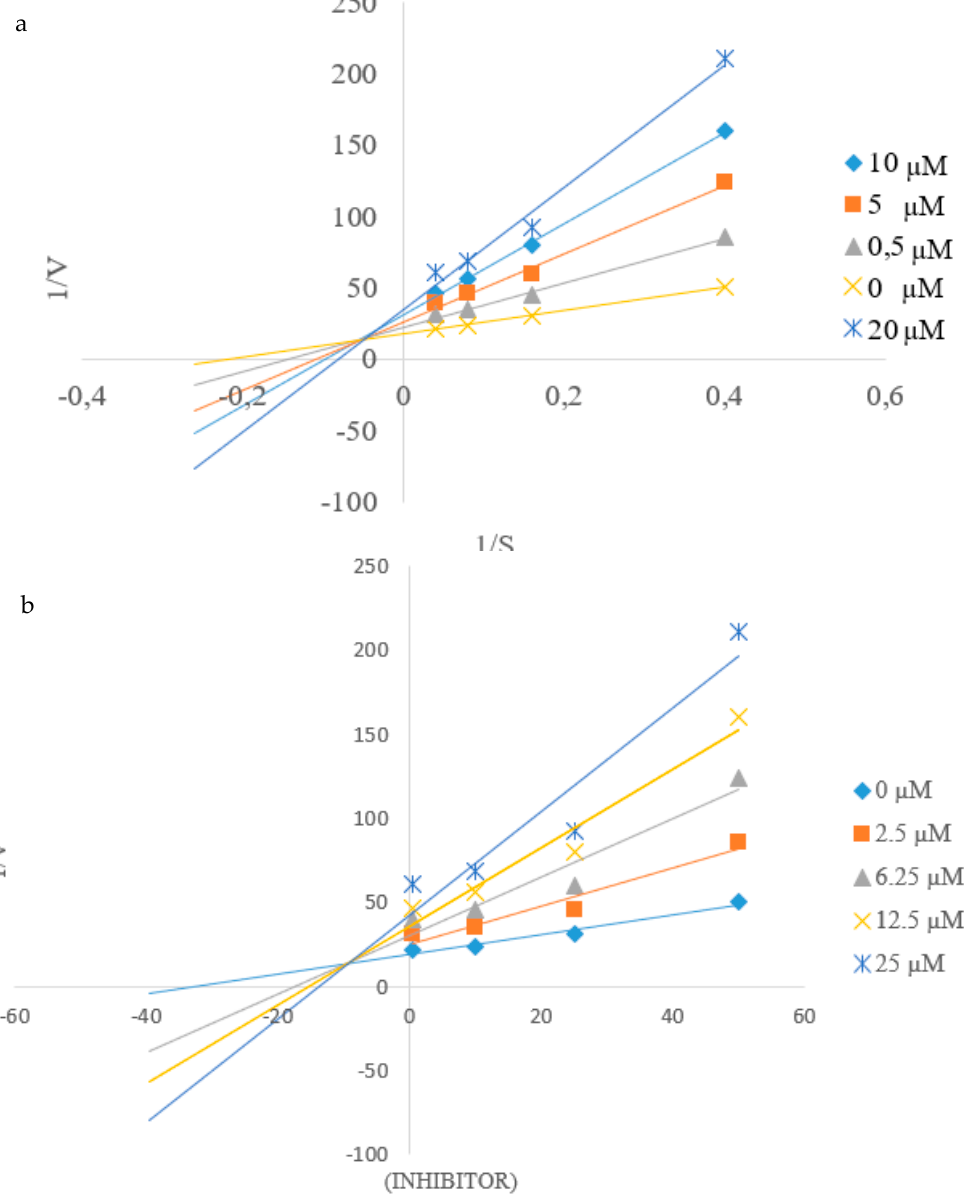
Figure 4. Lineweaver-Burk ( a ) and Dixon ( b ) plots for the inhibition of PTP1B by 2c .